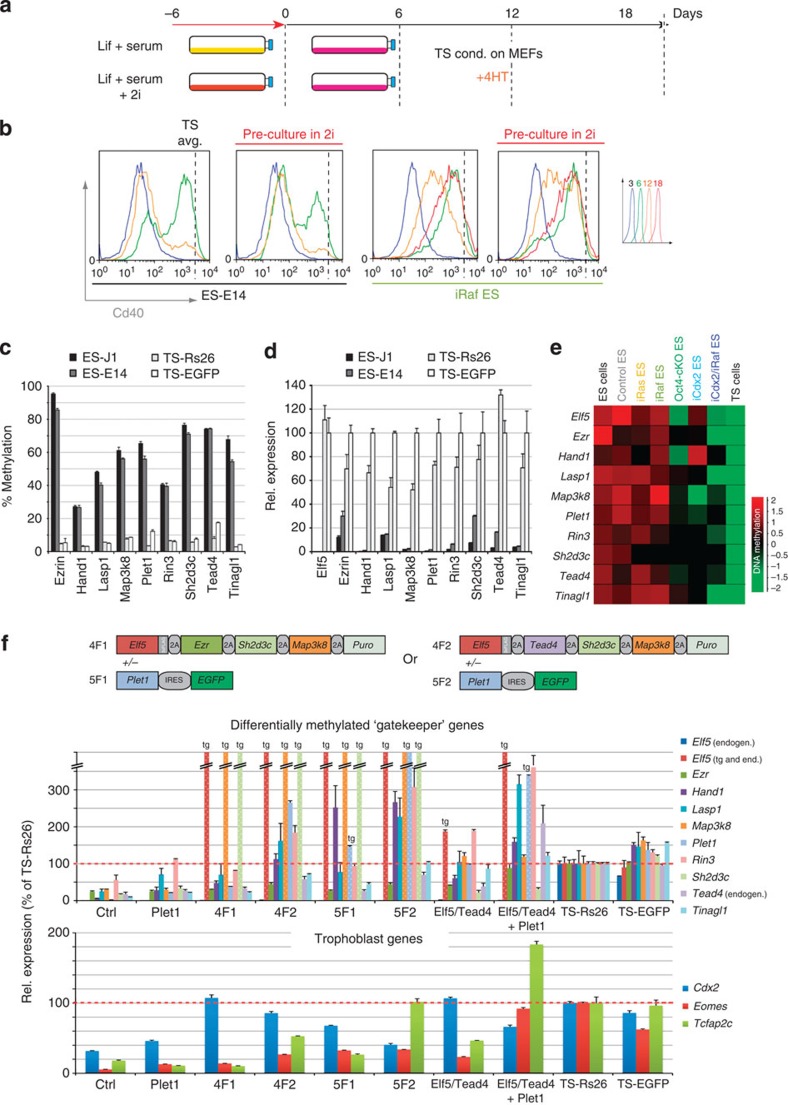
A persistent epigenetic memory at differentially methylated lineage gatekeeper genes.(a) Layout of the experimental protocol of pre-treatment of ES cells with Mek1/2 and Gsk3 inhibitors (2i) that push ES cells into the ground-state of pluripotency and induce global hypomethylation. (b) Time course of the acquisition of Cd40 surface antigen expression as in Fig. 2g revealed no further improvement to reprogramming. Data are of three biological replicates. (c) Sequenom analysis confirmation of the differential methylation status of nine genes identified by meDIP-seq (Fig. 3) that are, like Elf5, highly methylated in two independent ES cell lines but hypomethylated in TS cells. (d) RT–qPCR verifying the differential expression of these genes, with significantly higher expression levels observed in TS cells, as expected. Data are displayed as mean±s.e.m. of three replicates. (e) Heatmap of methylation reprogramming at these loci, focussed on the differentially methylated regions assessed in (a), across all TSL models. No single locus completely escaped reprogramming entirely, but also no single TSL model induced the most profound demethylation across all loci. (f) Generation of co-expression constructs driving concomitant expression of four to five gatekeeper genes as shown, or Elf5-Tead4-Puromycin (‘Elf5/Tead4’) separated by 2A sites only. E14 ES cells were (co-)transfected with these constructs and then cultured in TS cell conditions for 8 days. Expression levels of gatekeeper genes, as well as of the three important TS cell transcription factors Cdx2, Eomes and Tcfap2c, were determined by RT–qPCR. Values are expressed relative to TS-Rs26 cells as mean±s.e.m.